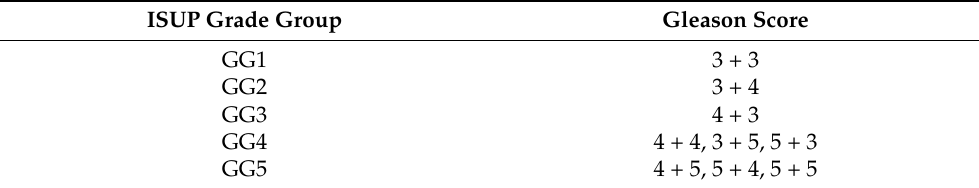
Table 1. Grade grouping based upon Gleason scores. ISUP Grade Group Gleason Score GG1 3 + 3 GG2 3 + 4 GG3 4 + 3 GG4 4 + 4, 3 + 5, 5 + 3 GG5 4 + 5, 5 + 4, 5 + 5 ISUP = International Society of Urological